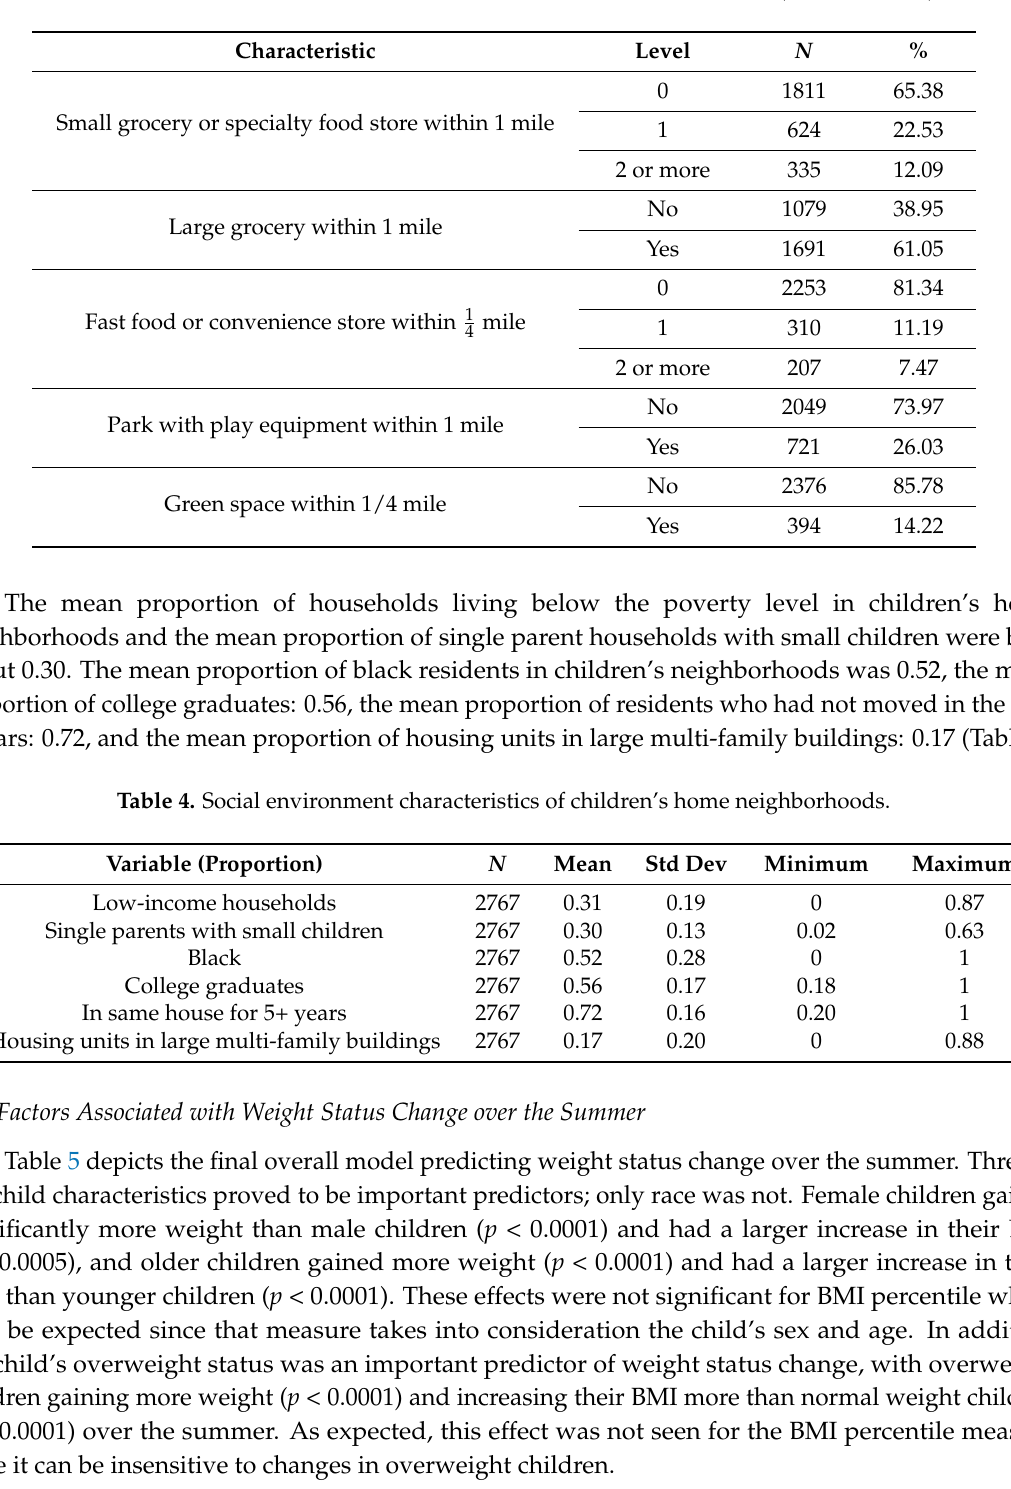
Table 3. Built environment characteristics within buffer of child’s home (Total N = 2770).